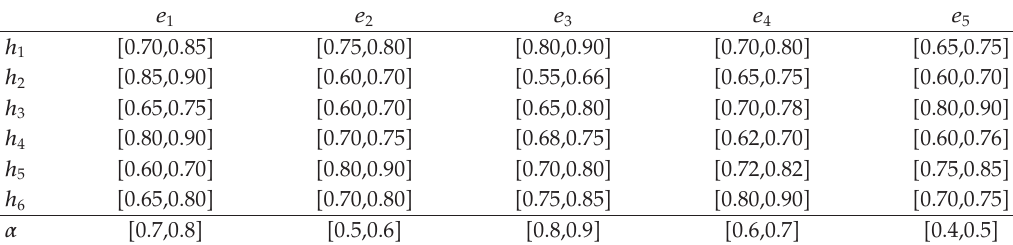
Table 1: Tabular representation of the GIVFS set (cid:2) F α .